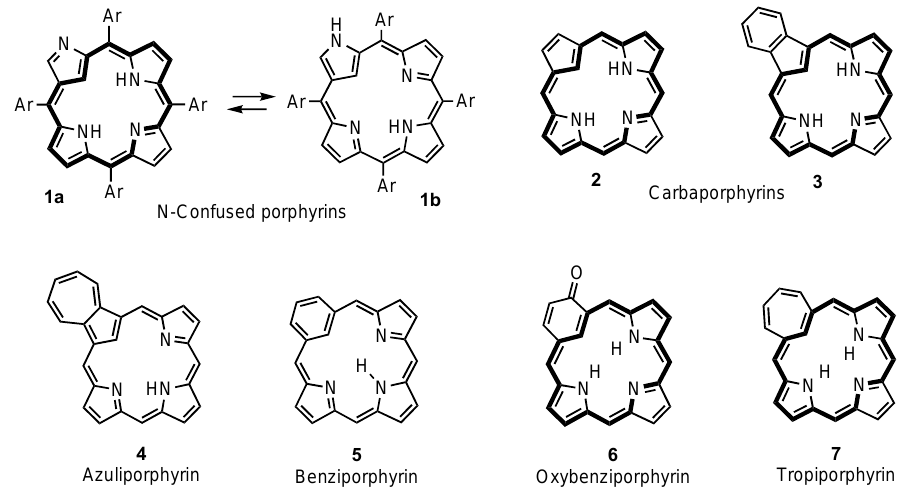
Figure 1. Selected carbaporphyrinoids.